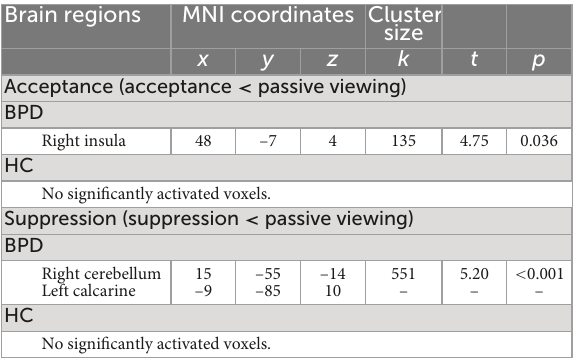
TABLE 2 Results of the whole-brain analyses indicating acceptance-related deactivation of the right insula and suppression-related deactivation of the right cerebellum and the left calcarine in subjects with borderline personality disorder (BPD) during the emotion regulation task.